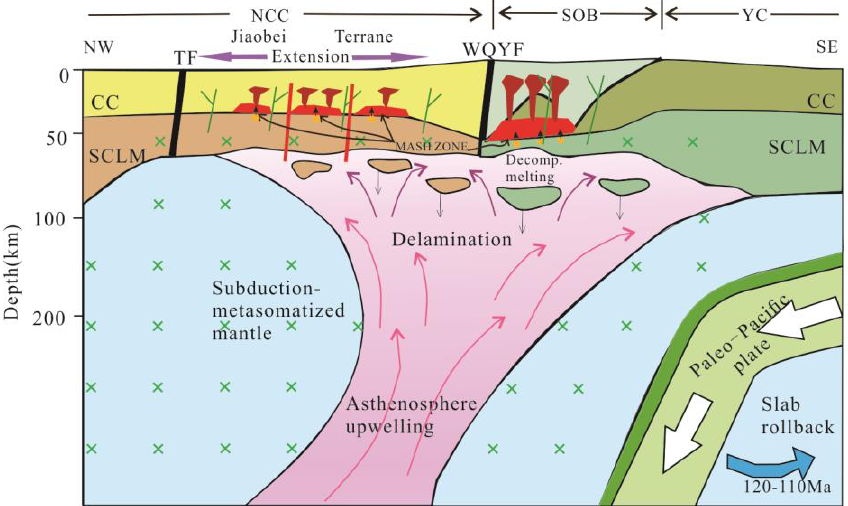
Figure 12. Schematic tectonic model illustrating the generation of the high Ba-Sr Dazeshan granitoids and their dark enclaves (see text for details). Adapted with permission from [33,47,52]. MASH—melting, assimilation, storage, and homogenization; SCLM—subcontinental lithospheric mantle; SOB—Sulu orogenic belt; NCC—North China craton; YC—Yangtze craton; CC—continental crust; WQYF—Wulian-Qingdao-Yantai Fault; TF—Tan-Lu fault.